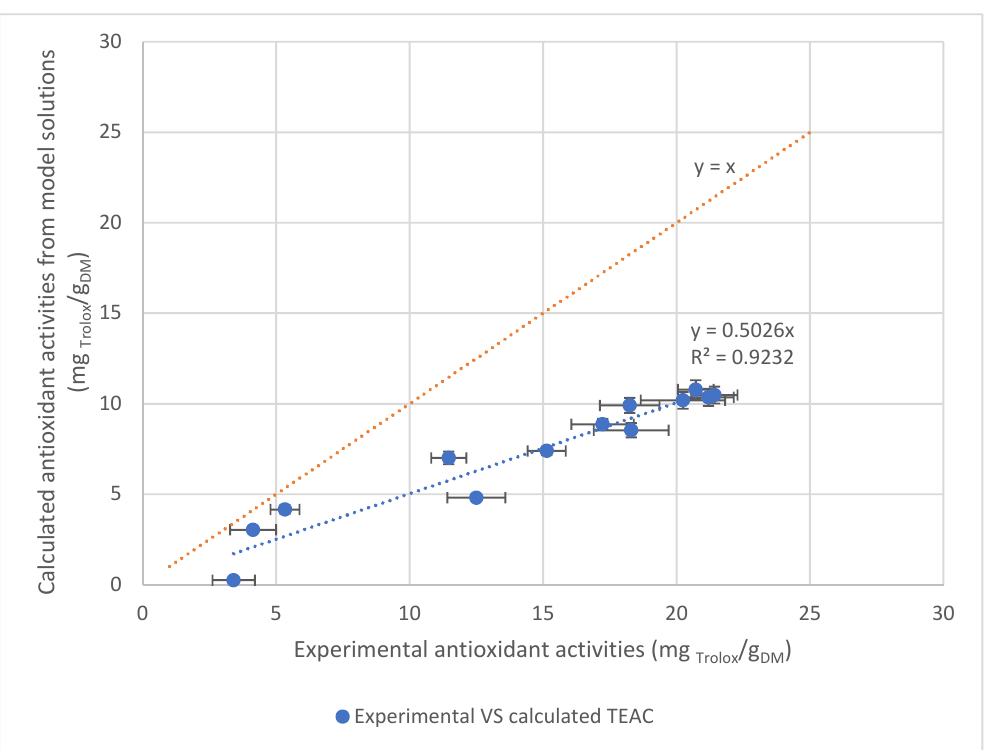
Figure 5 . Correlation between calculated and experimental TEAC . Figure 5. Correlation between calculated and experimental TEAC. If the measured TEAC values are perfectly predicted by the calculated values, the points will align with the bisector drawn in orange. However, the points are all below, indicating that the calculation underestimates the antioxidant activity of the extracts. A linear regression on all the points was carried out. The line, fitting the data with a coefficient of determination of 0.923, is a linear function with a slope equal to 0.5. For example, the TEAC measured for the central point is equal to 21.11 ± 0.36 mgTrolox/g